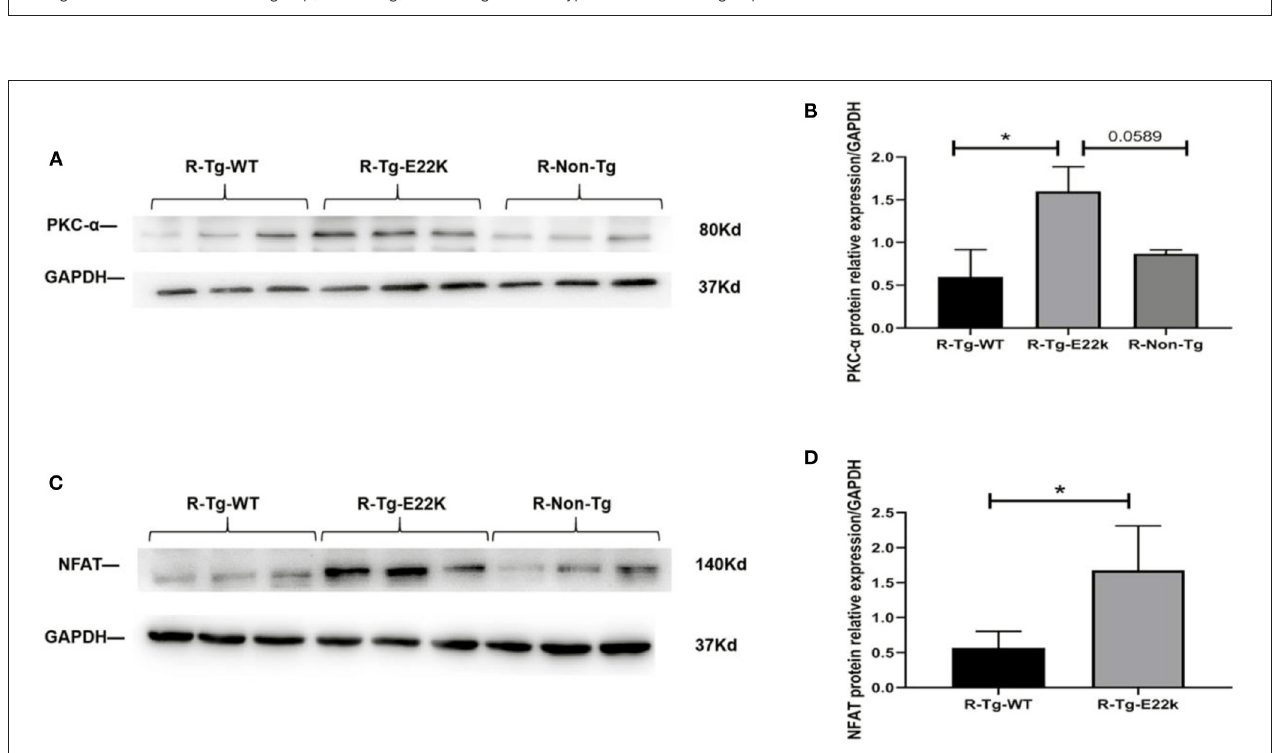
FIGURE 4 | E22K mutation upregulates the protein expression of PKC- α and NFAT. Representative Western blot data showing the upregulated expression levels of PKC- α and NFAT in R-Tg-E22K mouse hearts compared to R-Tg-WT and R-Non-Tg mouse hearts (A,C) . Densitometric analysis of the protein levels of PKC- α and NFAT in each group (B,D) . N = 3, * p < 0.05. R-Tg-WT, wild-type transgenic mice in the rest group; R-Tg-E22K, transgenic E22K mice in the rest group; R-Non-Tg, non-transgenic wild-type mice in the rest